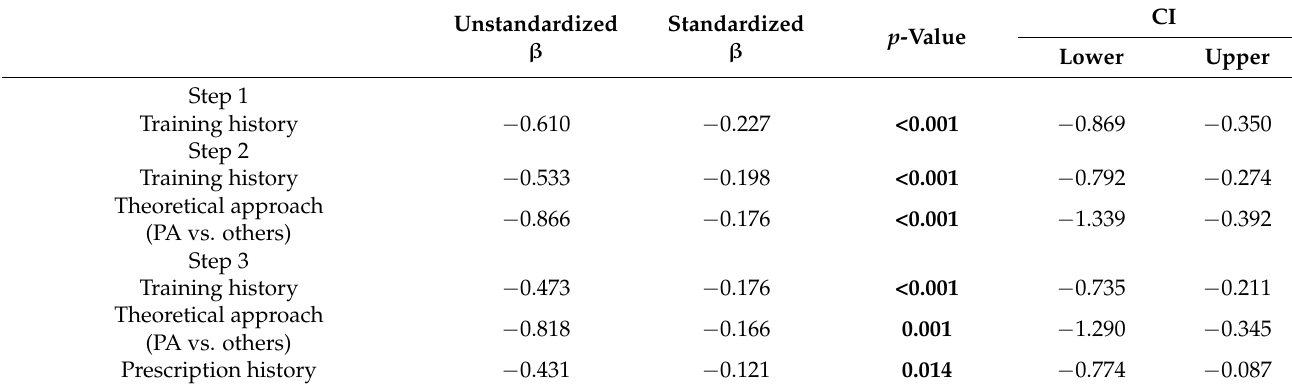
Table 6. Stepwise linear regression taking the overall acceptability score as the dependent